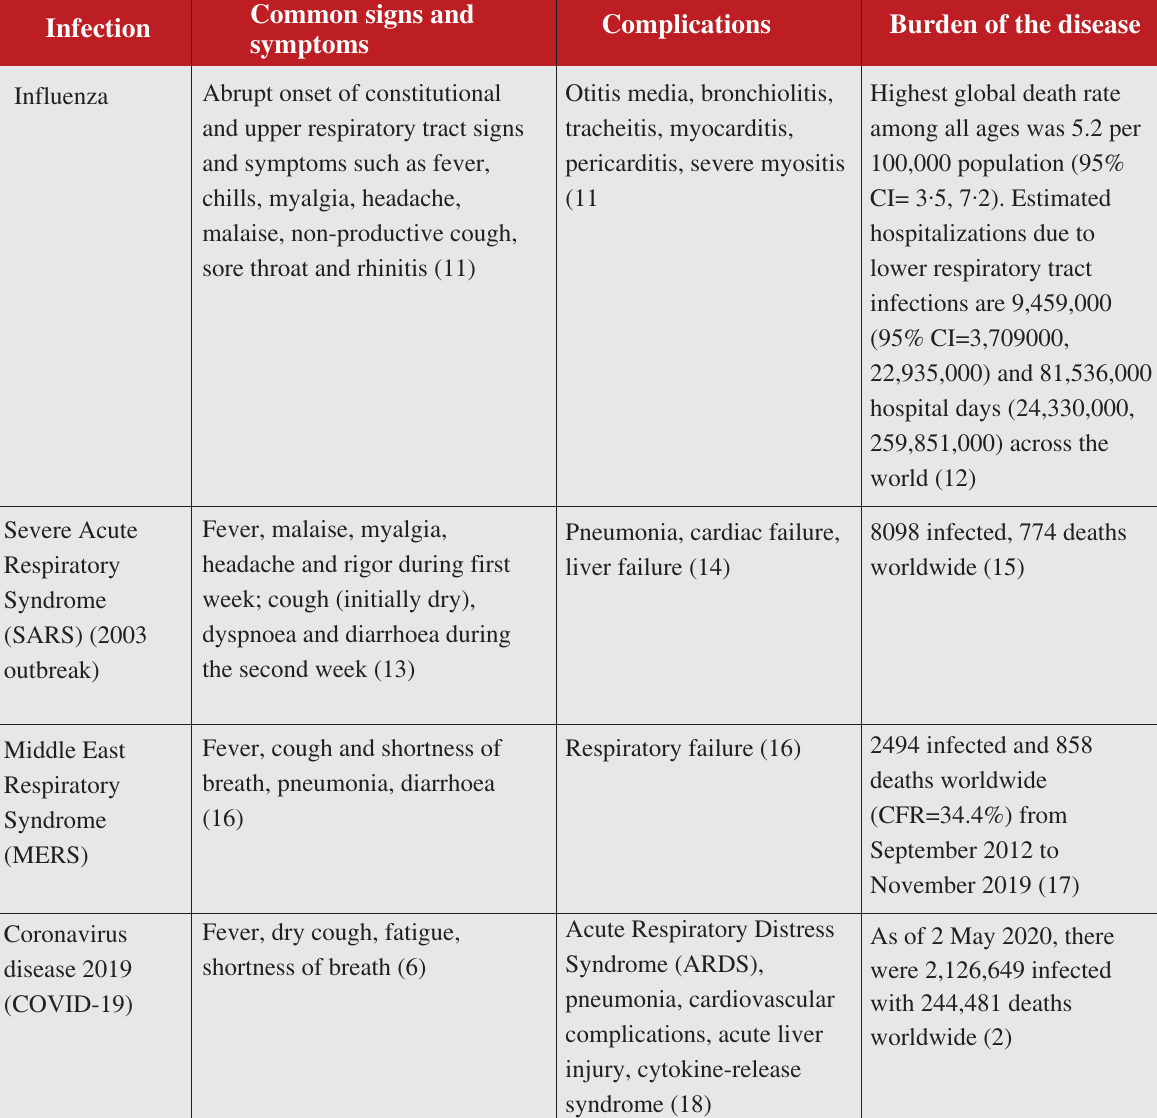
Table 1. Clinical presentations of recent respiratory viral infections Common signs and Infection